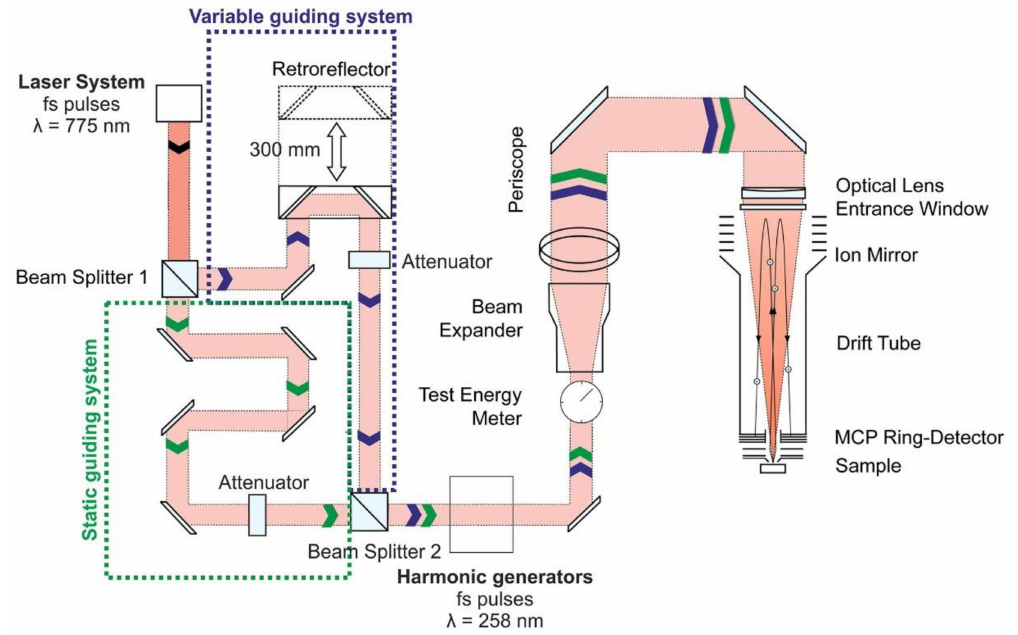
Figure 5. Schematic overview of laser ablation ionisation source with the mass analyser. Reprinted with permission from